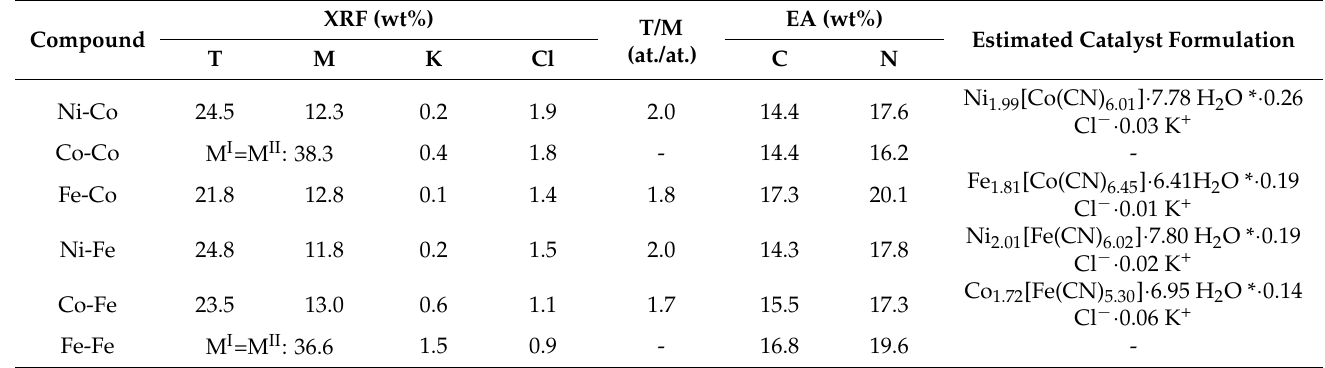
Table 5. Chemical composition of the studied porous